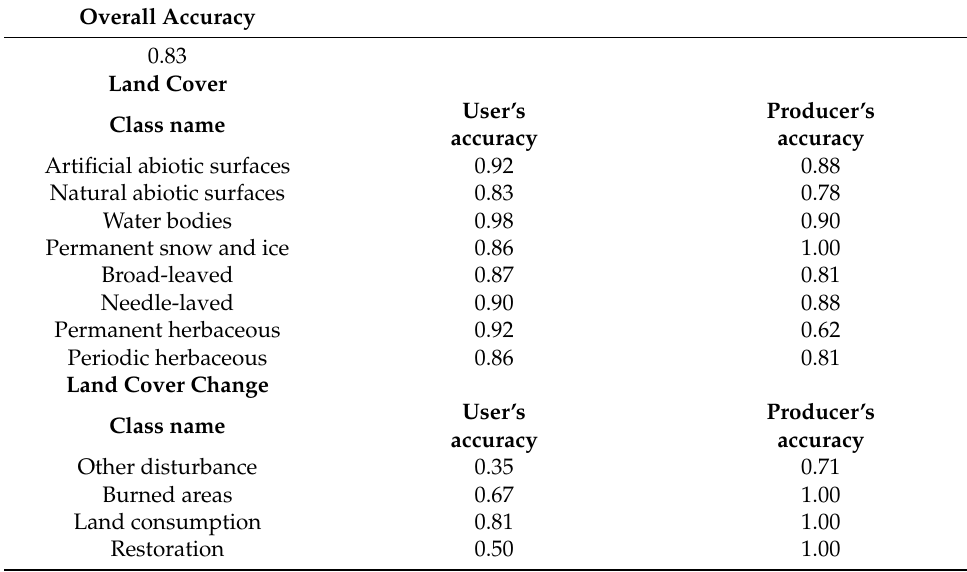
Table 7. Confusion matrix obtained from the accuracy